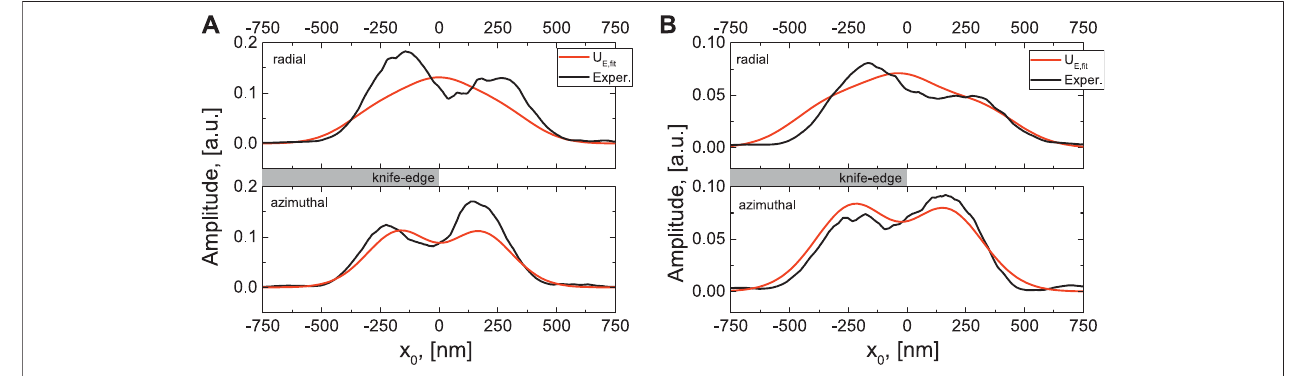
FIGURE 9 | Depiction of the adapted knife-edge method for tightly focused radially and azimuthally polarized beams. Experimentally measured projections of radially and azimuthally polarized beams (black) and their reconstructed beam pro fi les (red) for (A) λ (cid:1) 535nm, (B) λ (cid:1) 633nm.